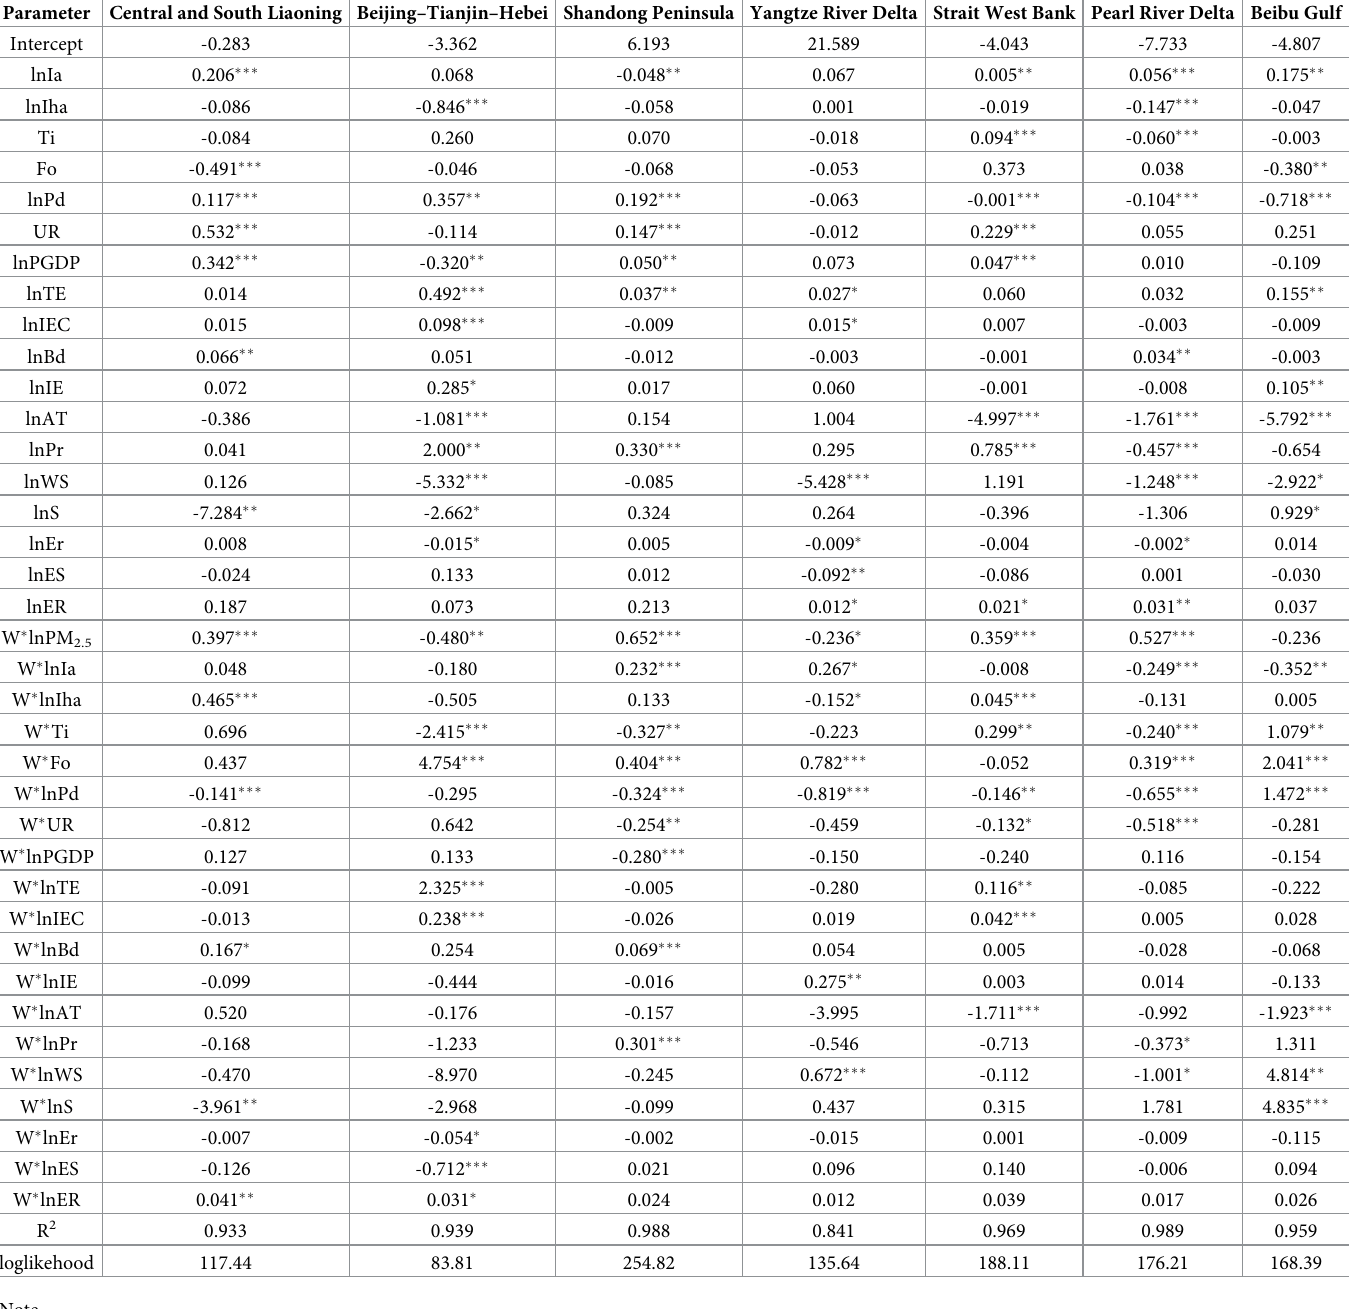
Table 4. Results from the SDM model of PM 2.5 pollution in China’s coastal urban agglomerations from